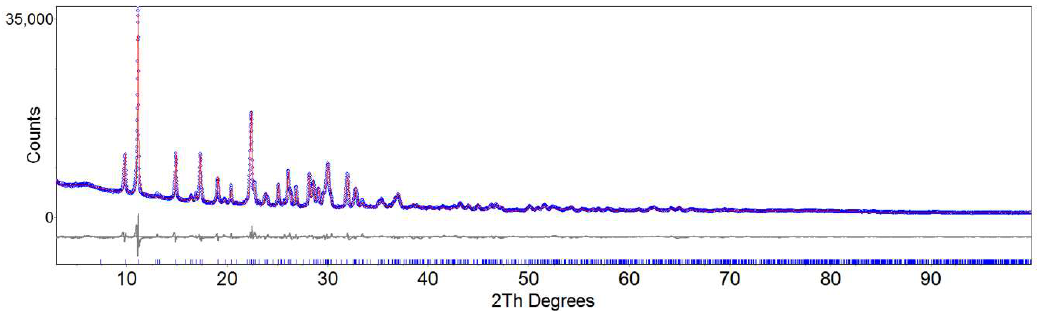
Figure 4. Difference plot of the powder XRD experimental and calculated pattern of Ba-clinoptilolite (90 °C, 22 d).